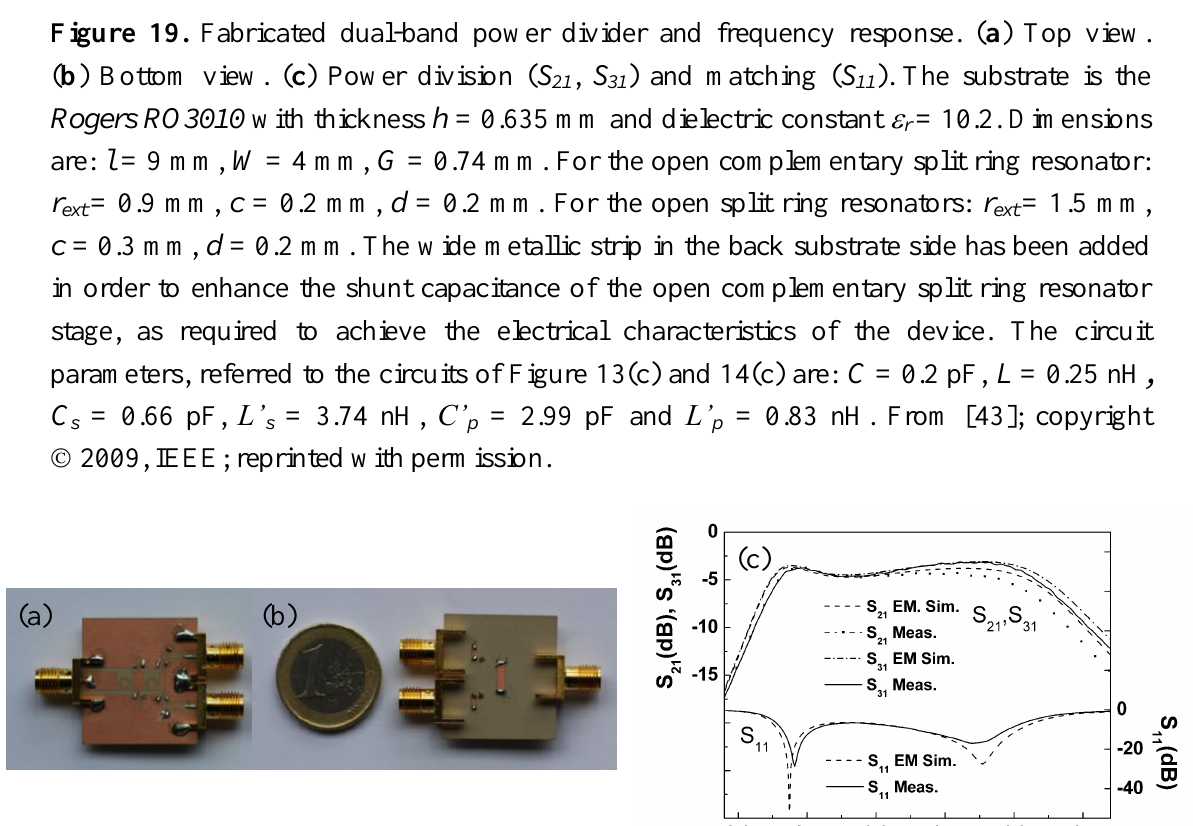
, S ) and matching ( S ). The substrate is the 21 31 11 = 10.2. Dimensions r = 1.5 mm, ext